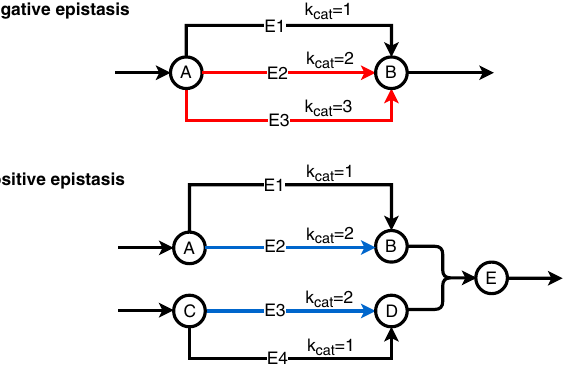
Figure 1. Illustrative examples of epistatic interactions that arise because of different enzymatic costs of pathways. ( a ) Negative epistasis between E2 and E3. ( b ) Positive epistasis between E2 and E3. The example assumes equal protein costs for all